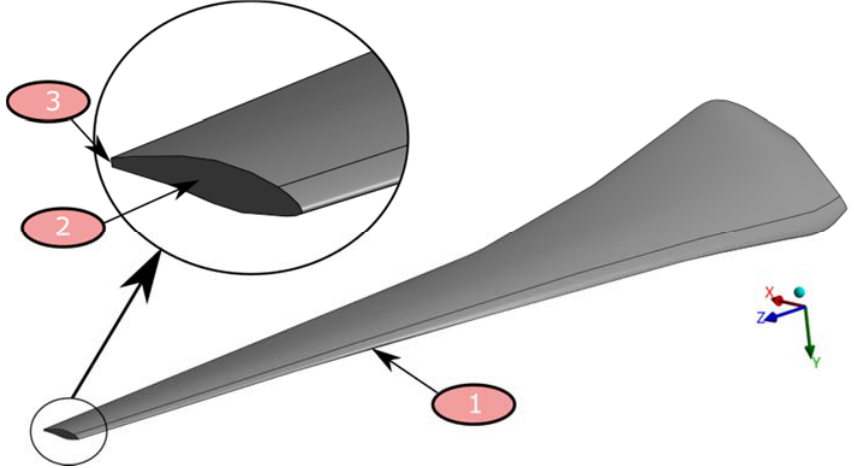
Figure 9. Mesh operations on the blade.